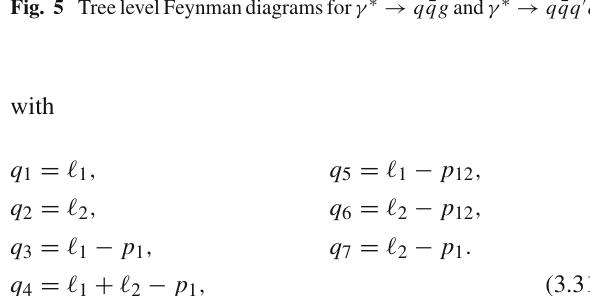
Fig. 5 TreelevelFeynmandiagramsfor γ ∗ → q ¯ qg and γ ∗ → q ¯ qq (cid:6) ¯ q